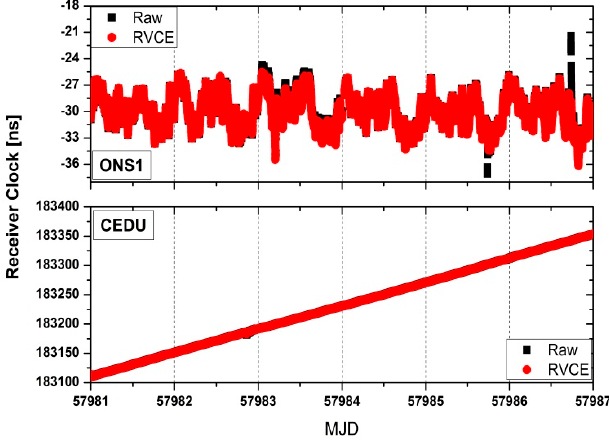
Figure 3. Receiver clock time series for station ONS1 and CEDU with and without the RVCE approach.